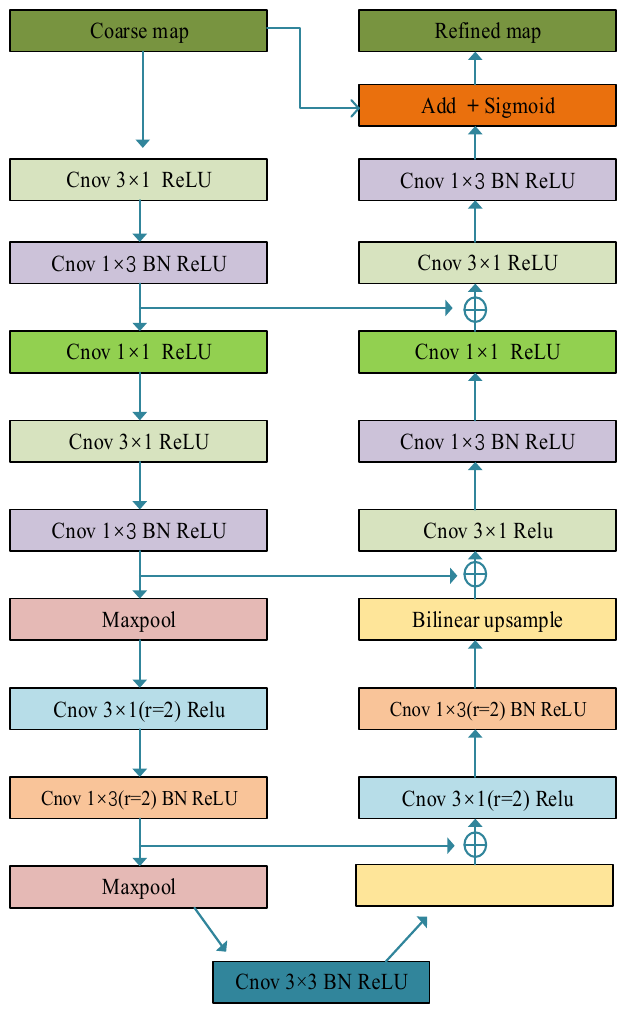
Figure 5. Refinement network structure diagram.